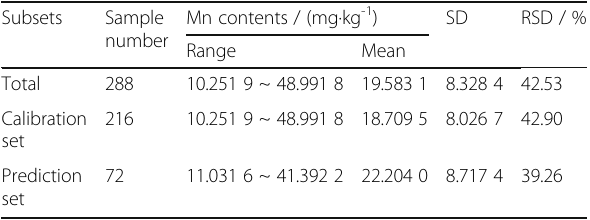
Table 1 The statistic of Mn content of sample in two sets by KS algorithm Subsets